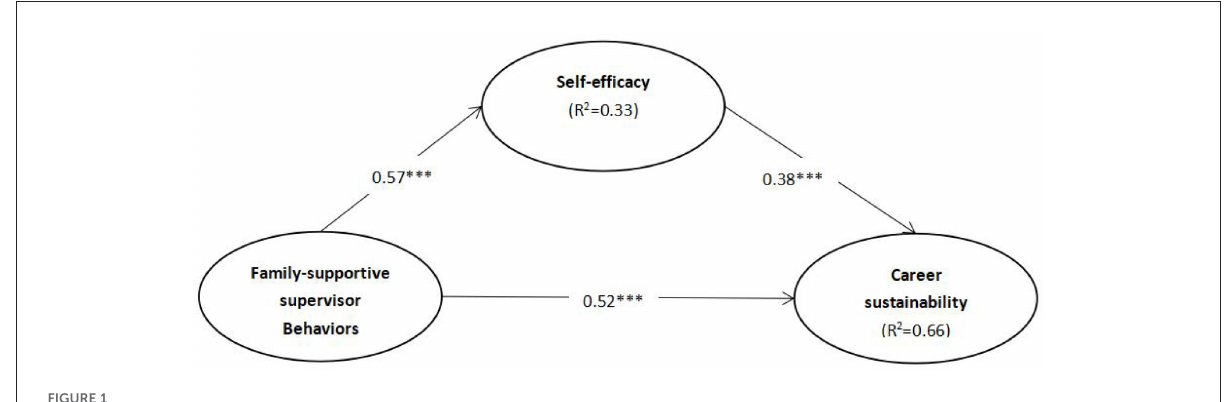
FIGURE1 PLS results outcomes. *** T >